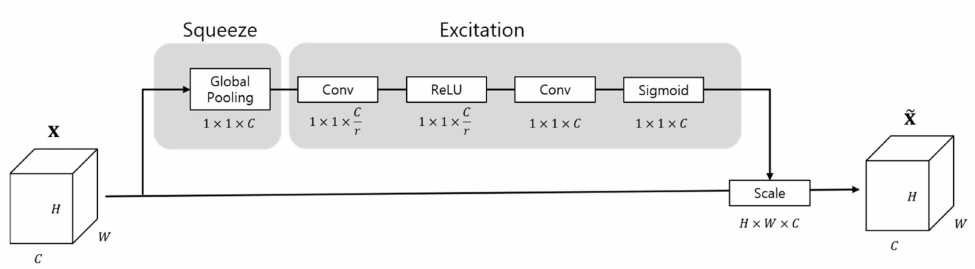
Figure 7. Structure of SEBlK. The squeeze step converts the feature maps of H × W of C channels into a feature map of 1 × 1 size. One value is obtained by averaging the two-dimensional feature map. That is, the H × W × C feature map is converted into a 1 × 1 × c feature map. The excitation step is performed to find out the relative importance of each channel through the feature map Conv and the activation function. The relative importance of each channel can be expressed as a value between 0 and 1, which is multiplied by x to obtain (cid:101) x in the scale